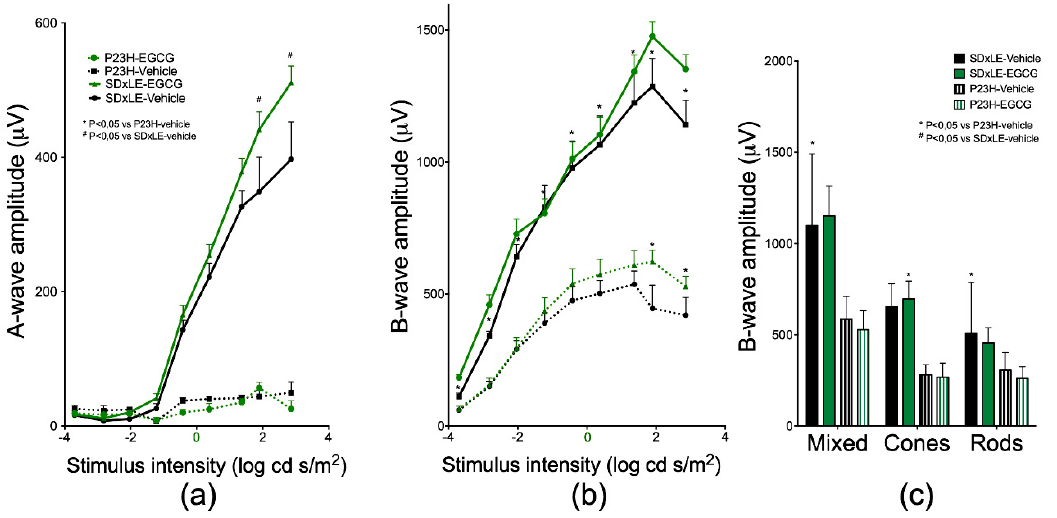
Figure 2. Scotopic ( a ) a- and ( b ) b-wave responses for flash intensities of 0.0002, 0.0015, 0.0092, 0.06, 0.38, 2.38, 23.19, 78, and 722 cd.s / m 2 and electroretinogram double flash protocol (at 1.4 log cd.s / m 2 ) ( c ) recorded at P180 in P23H and SD × LE treatment groups. Data are presented as mean ± standard error ( n = 5 per group). Mann–Whitney U test, * p < 0.05 versus P23H-vehicle animals, # p < 0.05 versus SD × LE animals.